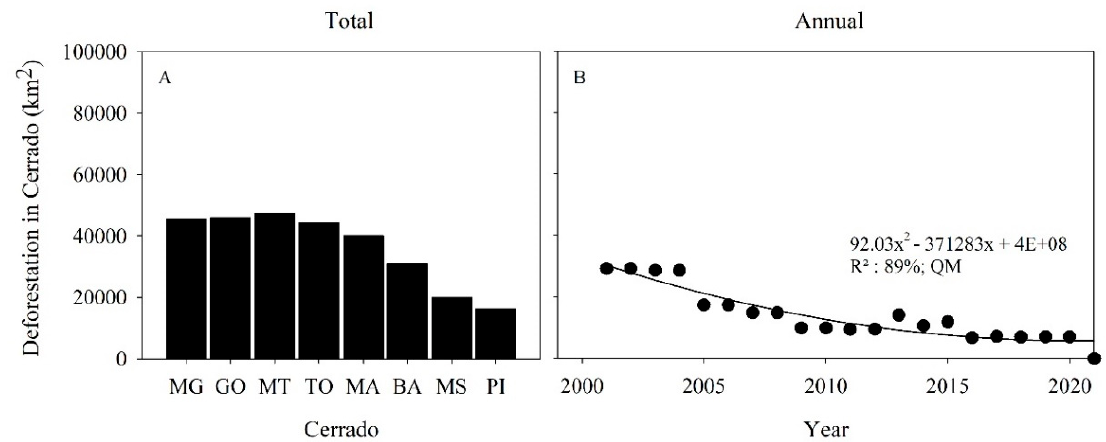
Figure 3. Total deforestation of Cerrado (km 2 ) in Minas Gerais (MG), Goiás (GO), Mato Grosso (MT), Tocantins (TO), Maranhão (MA), Bahia (BA), Mato Grosso do Sul (MS), and Piauí (PI) from 2000 to 2020. QM represents quadratic model. Total represents the sum of all years between 2000 and 2020.